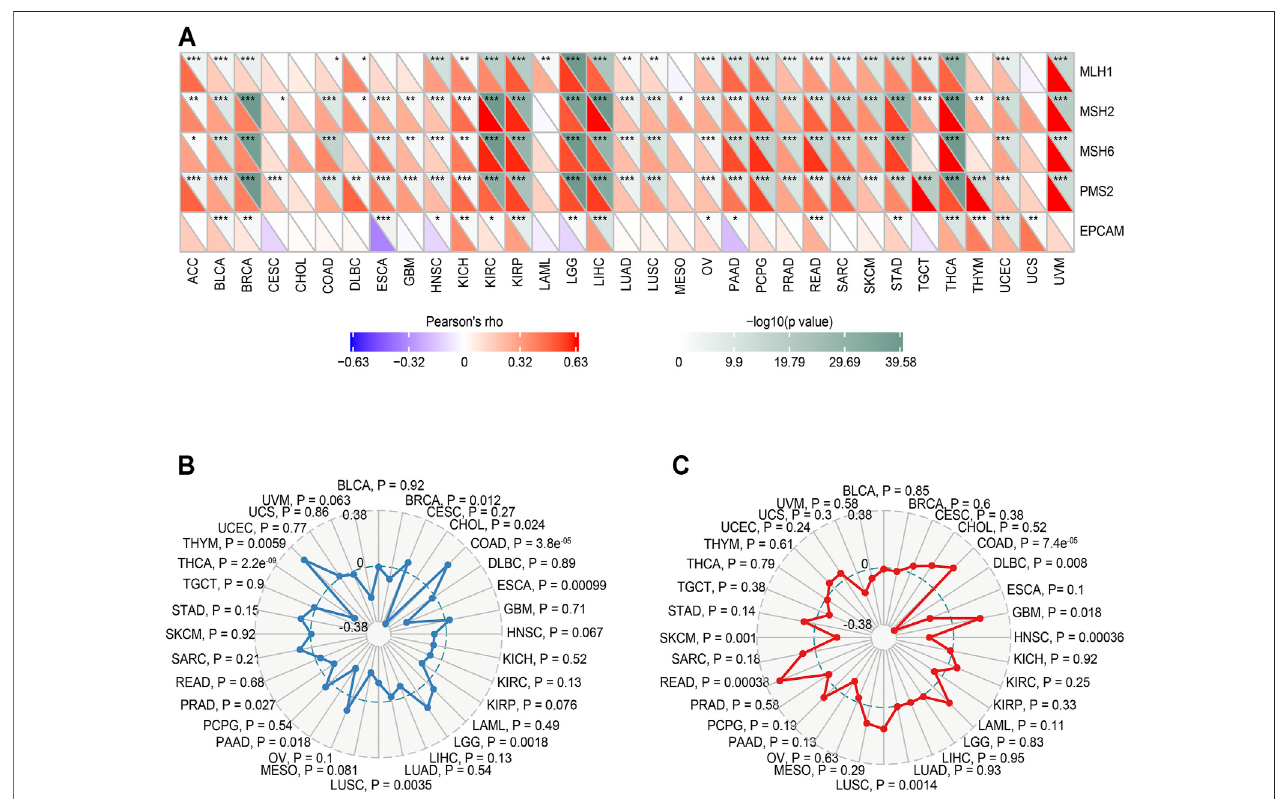
FIGURE7| Relationship betweenMMR defects, TMB,MSIand MALT1mRNAexpression levels invarioustumors intheTCGAdatabase. (A) Correlationbetween MALT1and fi vesigni fi cantMMRgenes(MLH1,MSH2,MSH6,PMS2,andEPCAM)in33typesofcancers.Thelowertriangleineachtileindicatescoef fi cientscalculated by Pearson ’ s correlation test, and the upper triangle indicates the log10-transformed P-value. *: p < 0.05, **: p < 0.01, ***: p < 0.001. (B) Correlation between TMB and MALT1 expression, theblackvalueisthescaleofthecorrelationcoef fi cient. (C) CorrelationbetweenMSIand MALT1expression, theblackvalueisthescaleofthe correlation coef fi cient. Spearman correlation test; p < 0.05 was considered signi fi